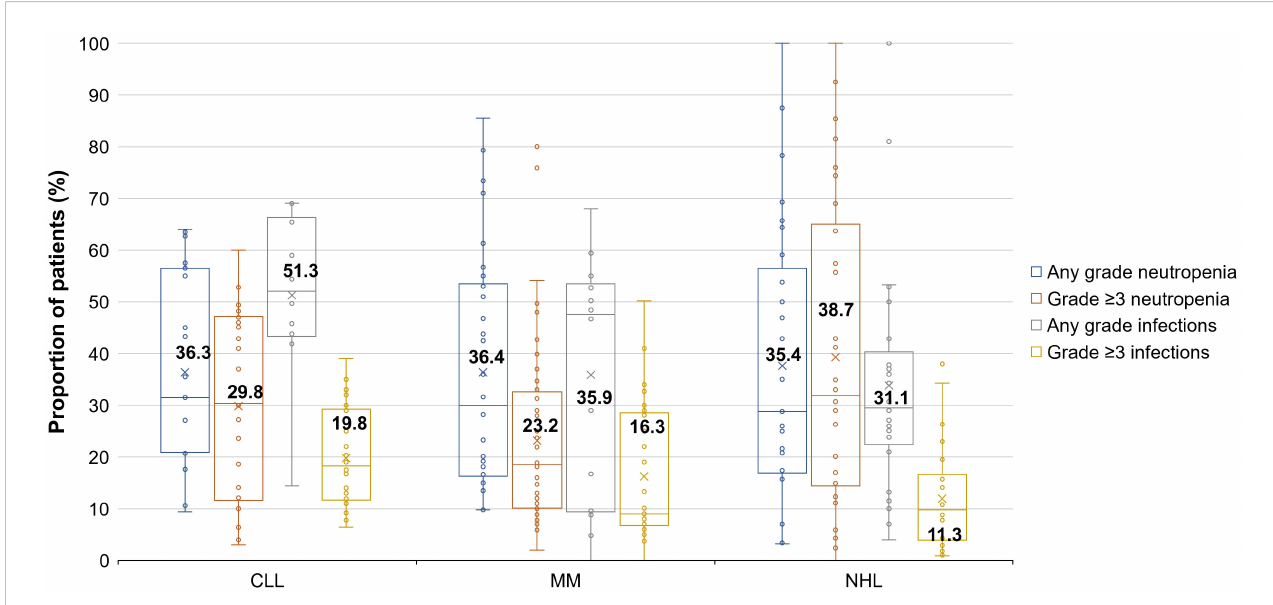
FIGURE 1 Proportions of patients with CLL, MM, and NHL who had infections (any grade and grade ≥ 3) or neutropenia (any grade or grade ≥ 3). Each box displays data distribution through their quartile (i.e., upper quartile, median, and lower quartile), with the bars representing the variability outside the upper and lower quartile (i.e., upper extreme and lower extreme). A dot outside the bars represents an outlier. The x symbols and corresponding data label represent the mean values for each data set. Not all studies reported values for both any grade and grade ≥ 3 events; this has led to the situation where in some categories, individual studies reported higher levels of grade ≥ 3 events than other studies did for any grade events, leading to the average of grade ≥ 3 events being higher than the average for any grade events Neutropenia grades: grade 1, less than the lower limit of normal – 1,500 per mm 3 ; grade 2, 1,499 – 1,000 per mm 3 ; grade 3, 999 – 500 per mm 3 ; grade 4, <500 per mm 3 ; grade 5, death. Infection grades: grade 1, – ; grade 2, localized, local intervention indicated; grade 3, IV antibiotic, antifungal, or antiviral intervention indicated, interventional radiology or operative intervention